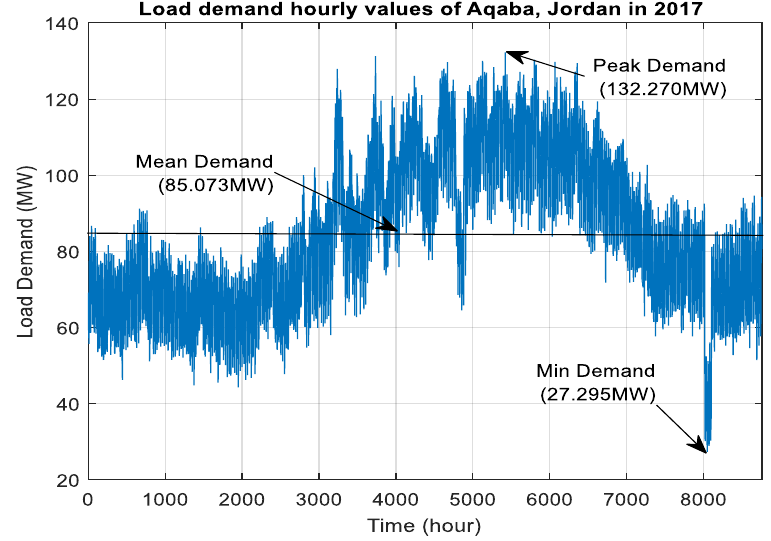
Figure 3. Load demand hourly values of the Aqaba Qasabah district in 2017.